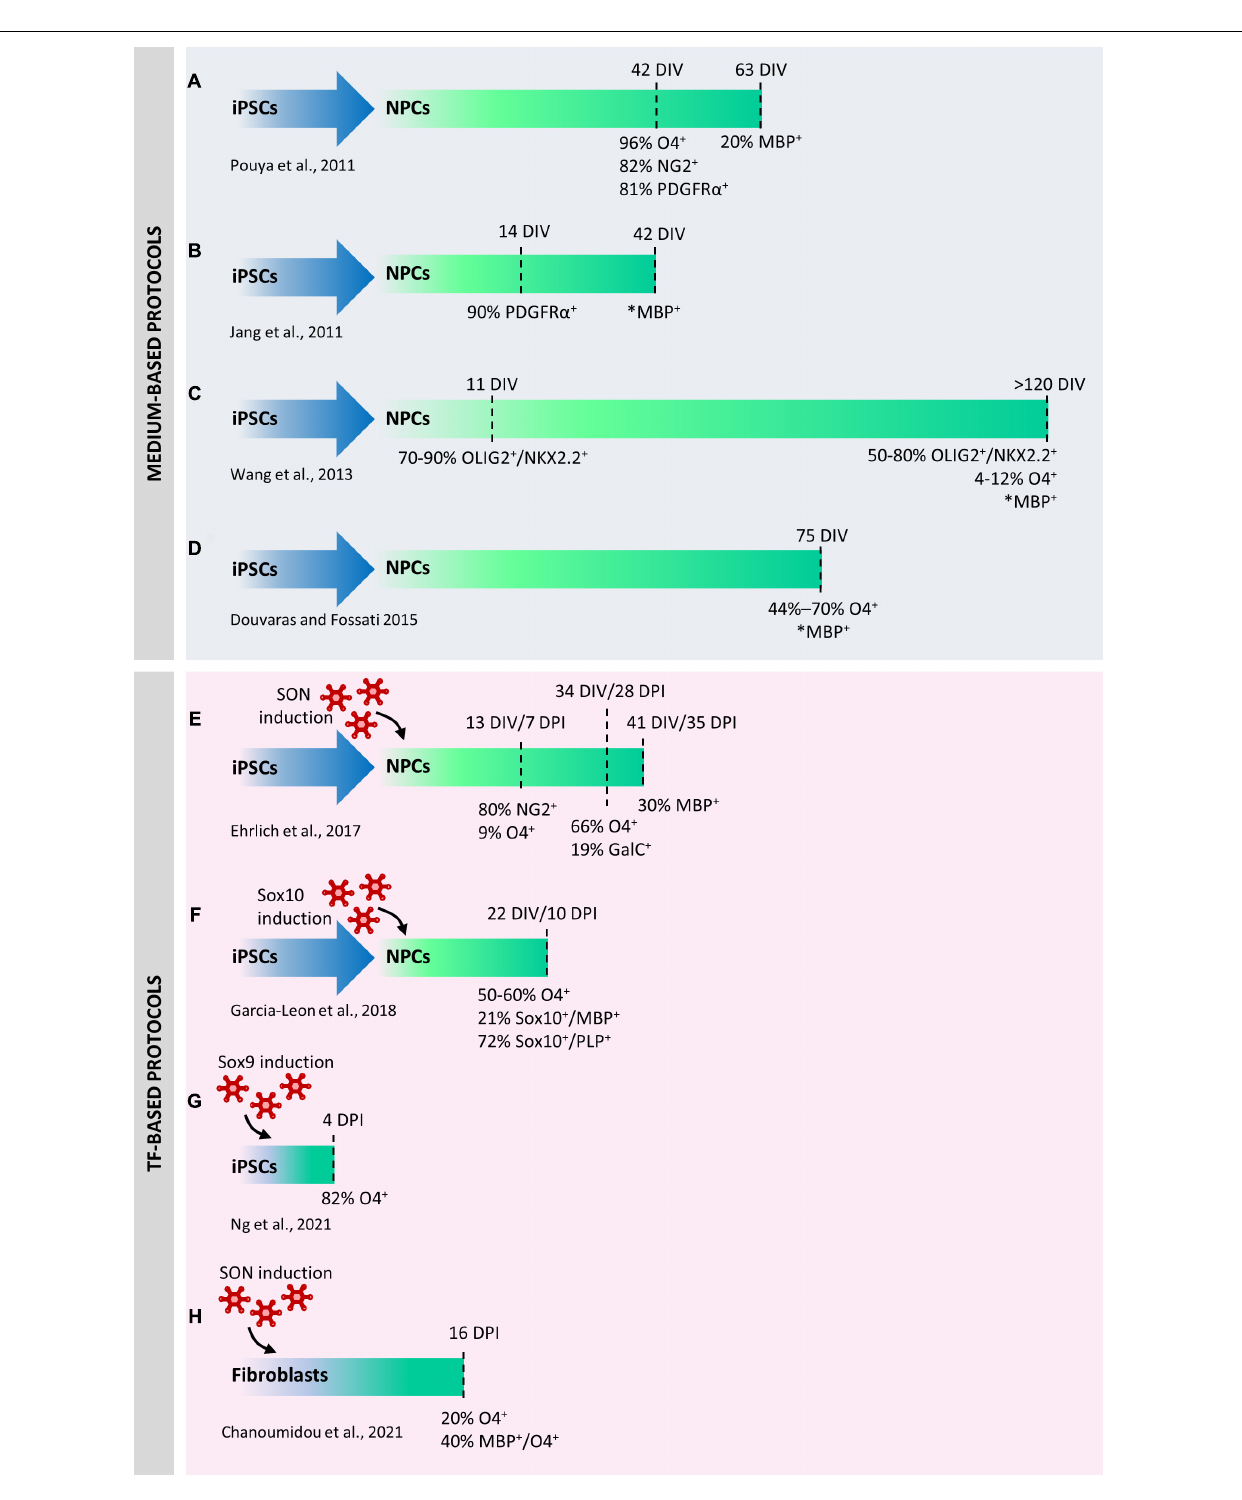
Frontiers in Cellular Neuroscience |